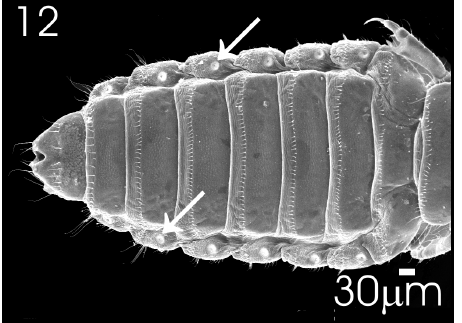
Fig. 15. Characteristic posterio-lateral flaps (F) of the female gonopods with a single terminal row of long setae (S) on each flap. (GO = genital opening).